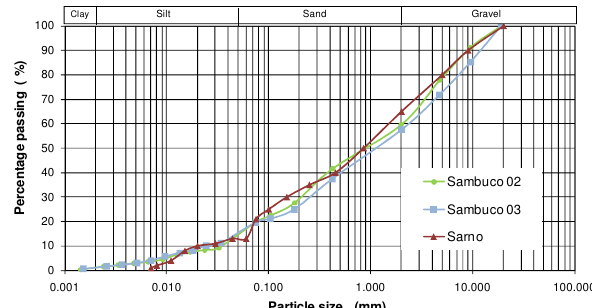
Fig. 6. Granulometric Figure 6. Granulometric curves. 2